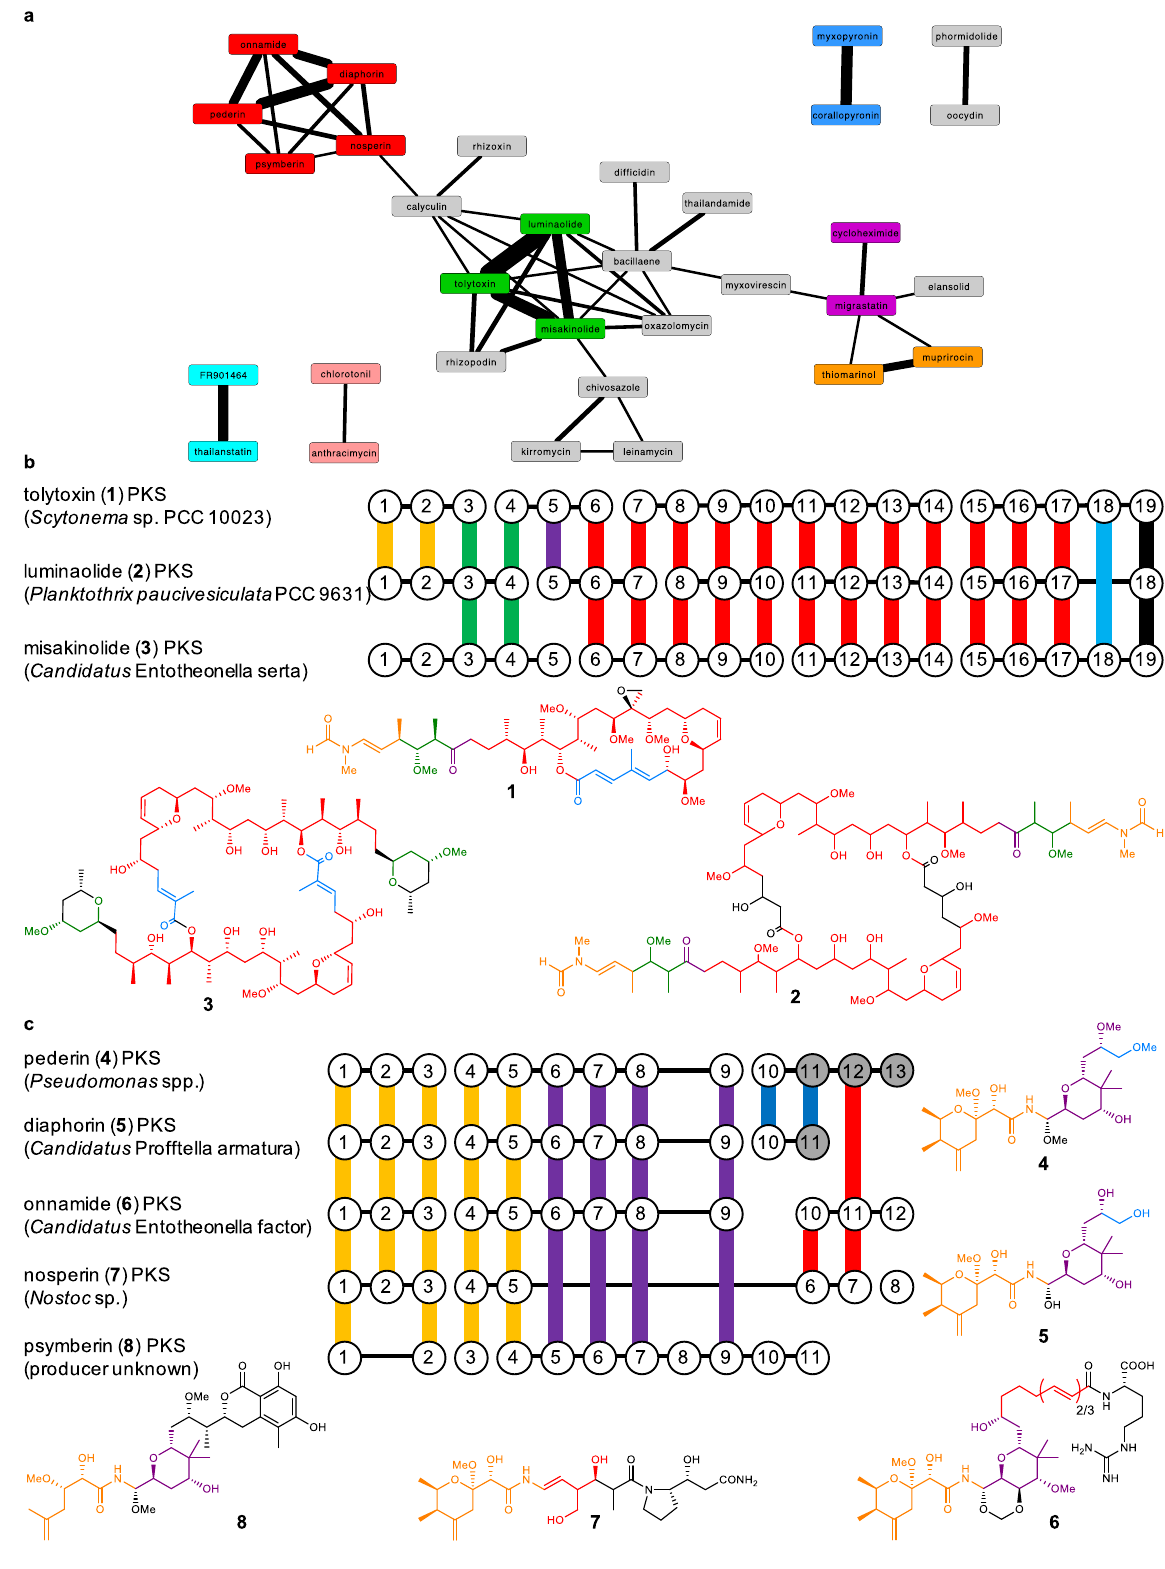
placement algorithm 32,33 implemented into the trans PACT work fl ow was used to place each sequence onto the reference tree to assign them to functional clades. If a KS domain was mono- phyletic with an annotated isofunctional clade, the annotation was transferred; if not, the KS domain was annotated as a domain of